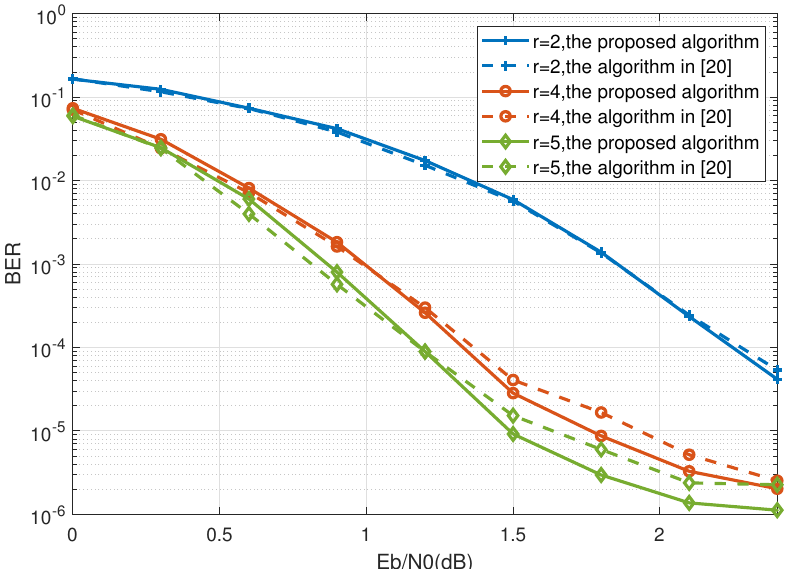
Figure 7. BER performance of turbo-Hadamard codes with different orders of Hadamard